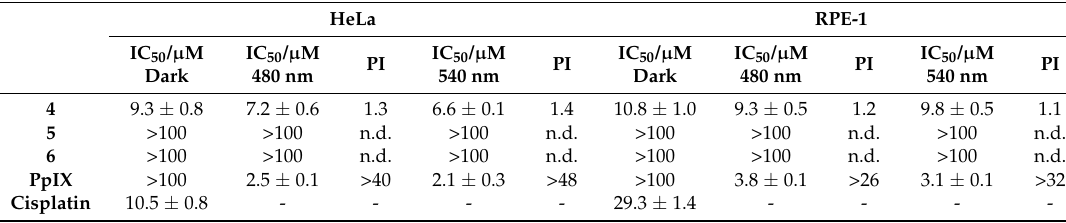
Table 3. IC 50 values in the dark and upon irradiation for the complexes 4 – 6 incubated in human cervical carcinoma (HeLa) and non-cancerous retinal pigment epithelium (RPE-1) cells. Average of three independent